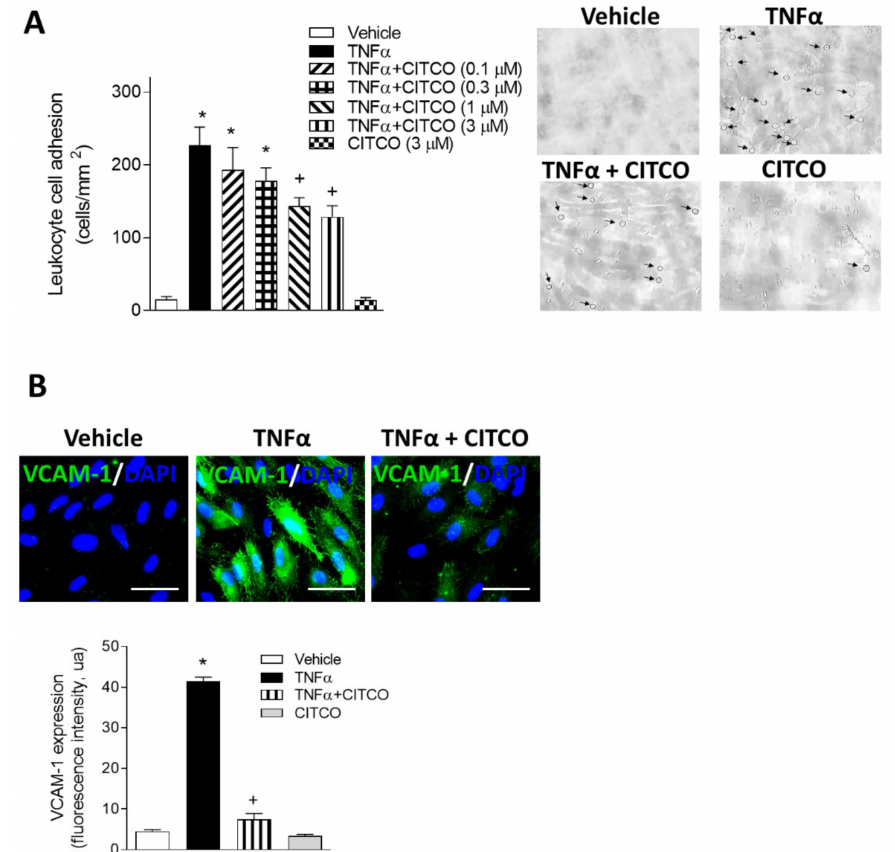
Figure 2. Effect of CITCO on leukocyte–endothelial cell interactions under physiological flow conditions. ( A ) HUVEC were treated with vehicle (0.1% DMSO) or CITCO (0.1–3 µ M) for 24 h and then stimulated with TNF α (20 ng/mL, 24 h). Next, whole blood from healthy volunteers was perfused across the endothelial monolayers for 5 min at 0.5 dynes/cm 2 , and leukocyte adhesion was quantified. Data are mean ± SEM ( n = 8 for each group). * p < 0.05 relative to vehicle group, + p < 0.05 relative to TNF α stimulated cells. Representative images of leukocyte adherence to HUVEC monolayers under different treatment conditions are also shown. Arrows indicate adhered cells. ( B ) Effect of CITCO on VCAM-1 expression. Cells were pretreated with vehicle (0.1% DMSO) or CITCO (3 µ M) 24 h before TNF α stimulation (20 ng/mL, 24 h). Representative images of VCAM-1 expression in HUVEC are shown. Immunoreactivity was visualized using an Alexa Fluor 488 secondary antibody (VCAM-1, green). Nuclei were counterstained with DAPI (blue). Scale bar = 50 µ m. Values are expressed as mean ± SEM, n = 3. * p < 0.05 relative to vehicle group, + p < 0.05 relative to TNF α -stimulated